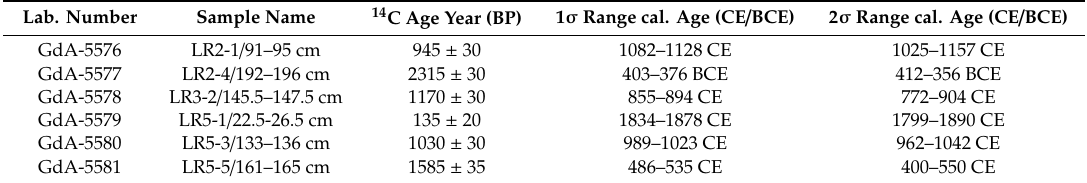
Table 2. Radiocarbon ages and calibration. A sample name is composed of the name of the core-number of the sample + the depth of the